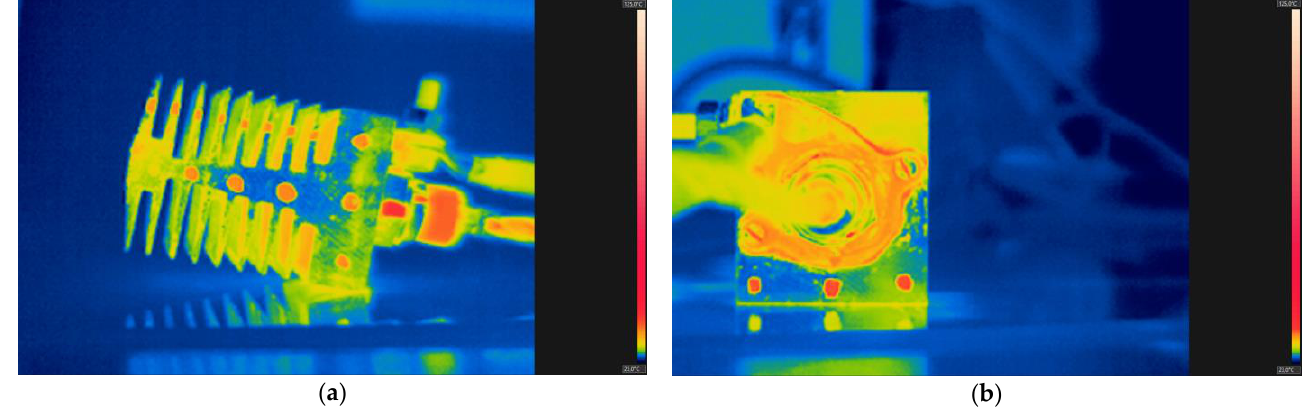
Figure 4. The thermograms showing the heat sink for a power of P j = 11.56 W: ( a ) side view; ( b ) top view. The temperature on the thermogram ranges from 23 °C to 125 °C.